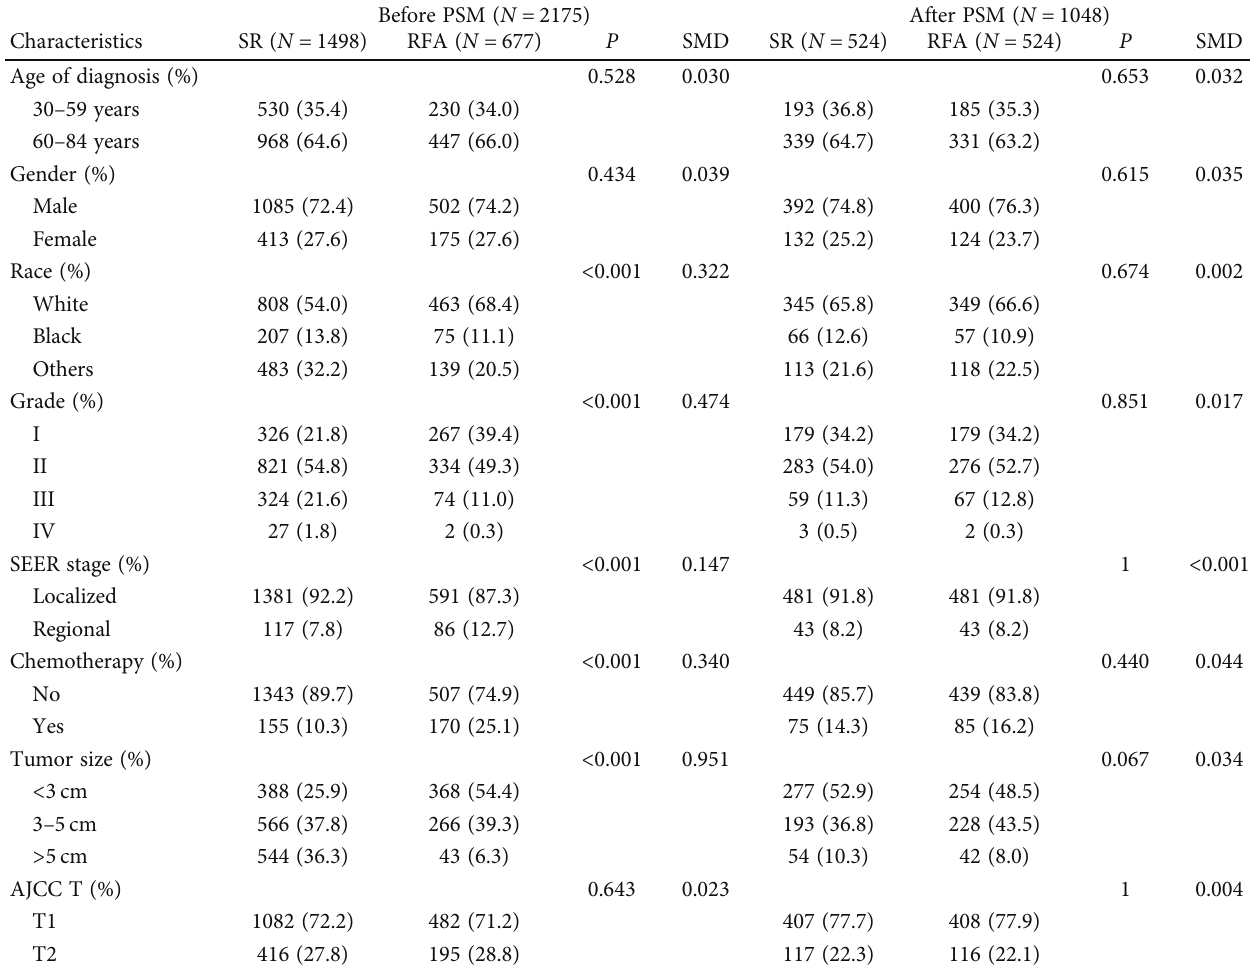
Table 1: Characteristics of